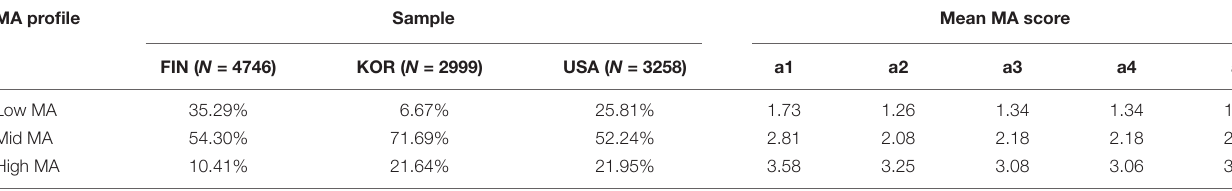
TABLE 5 | Differences in profile sizes across the Finnish, Korean, and American